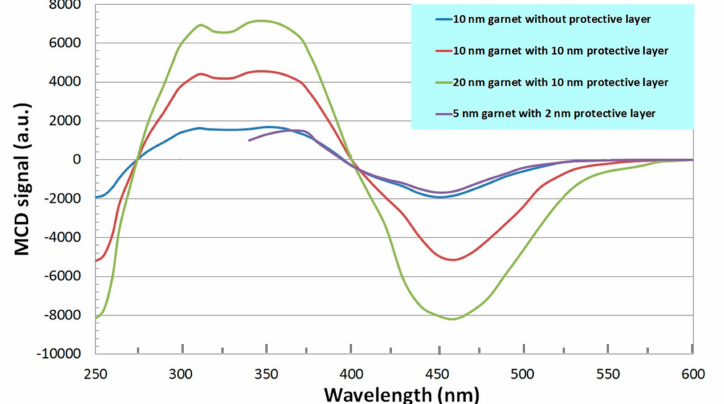
Figure 2. Spectral dependences of the magnetic circular dichroism of ferrite garnet films, in the spectral range from 250 to 600